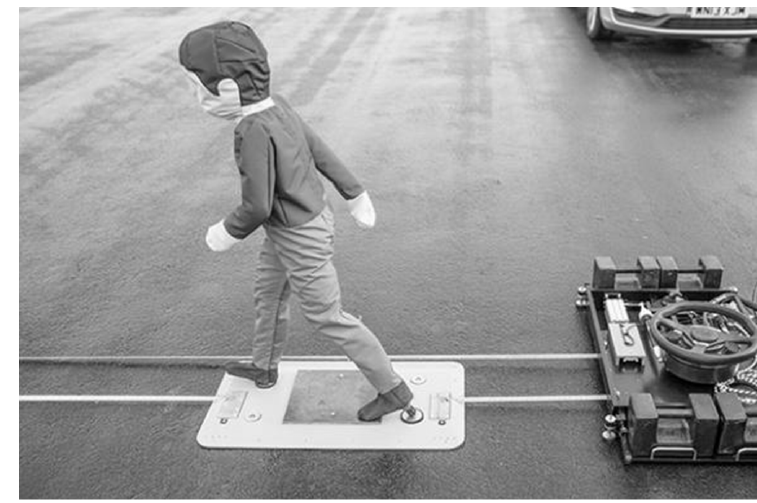
Figure 2. Child soft pedestrian target (SPT) for AEB system tests.